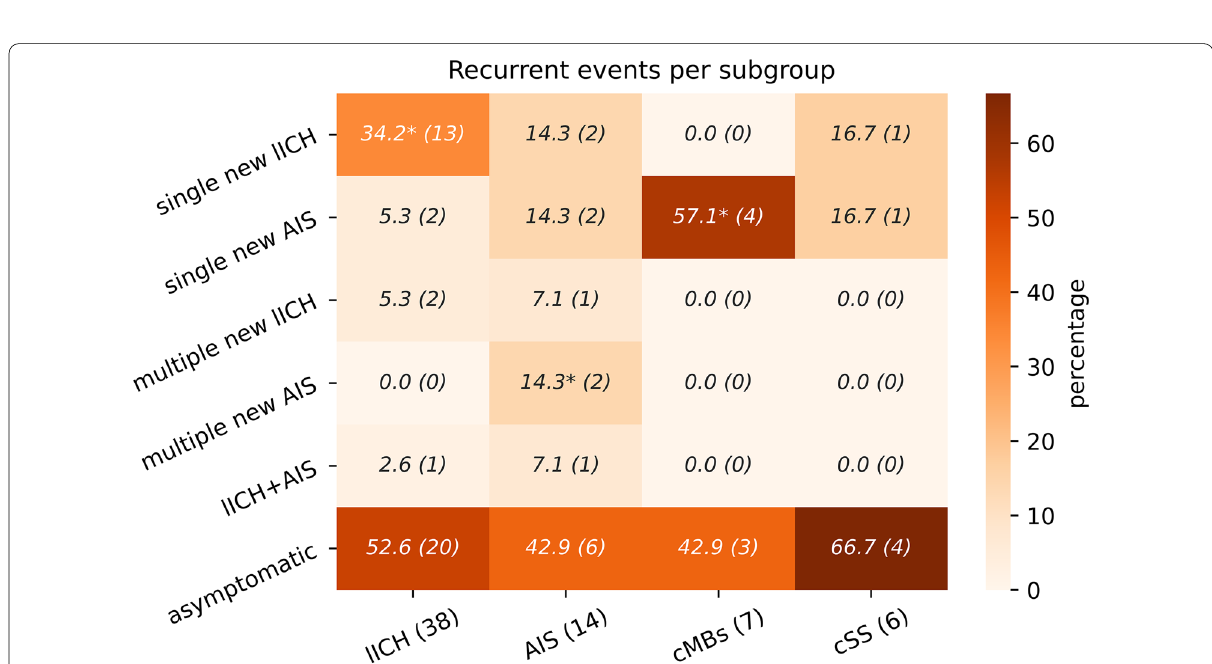
Fig. 2 Recurrent events (on left hand side) grouped by index event (at bottom line); * (cross‑row) (numbers: percentages per subgroup, number in parentheses: absolute patient